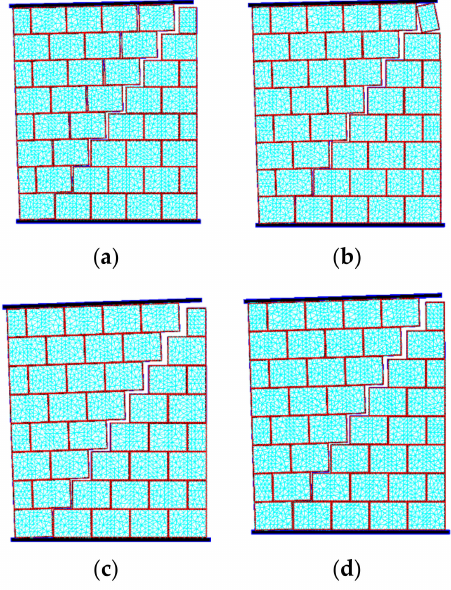
Figure 13. Final stone wall displacement configuration for a horizontal displacement of 40 mm: ( a ) 100 kN pre-compression vertical load—H-FEM-DEM-wall; ( b ) 250 kN pre-compression vertical load—H-FEM-DEM-wall; ( c ) 100 kN pre-compression vertical load—H-FEM-DEM-ball; ( d ) 250 kN pre-compression vertical load—H-FEM-DEM-ball.